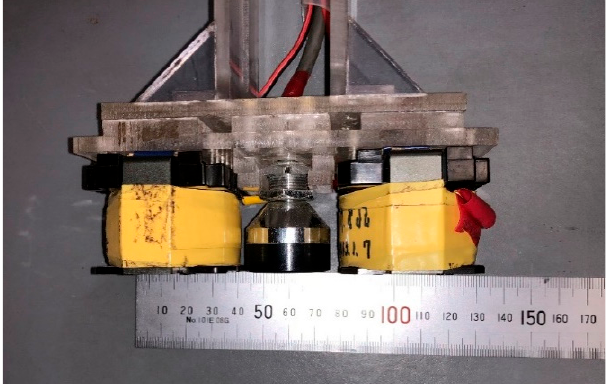
Figure 3. Photograph of an electromagnet. θ